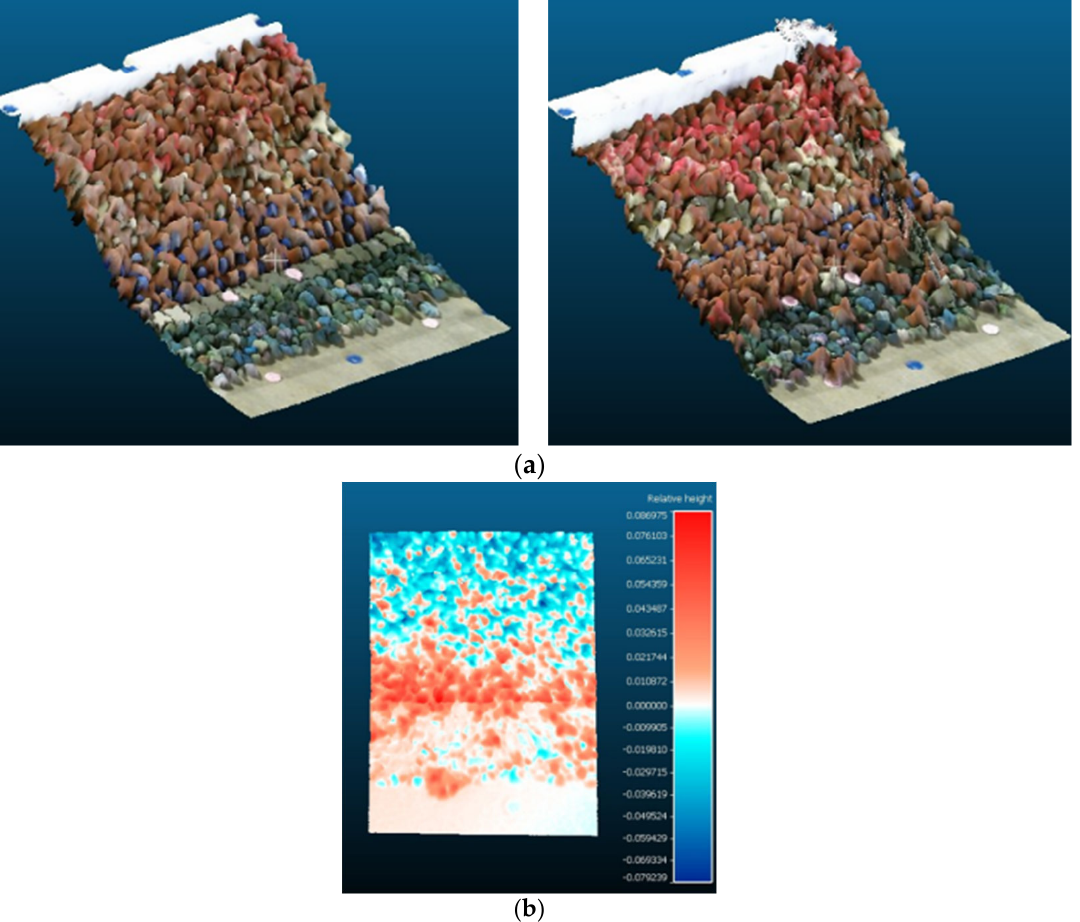
Figure 5. Survey conducted at the beginning and at the end of test series A. ( a ) Clouds of points of initial and final surveys; ( b ) distance map. Table 3. Damage values (S) measured and predicted by Melby’s formula (Equation (6)) and coefficients for armour layer made of rock.